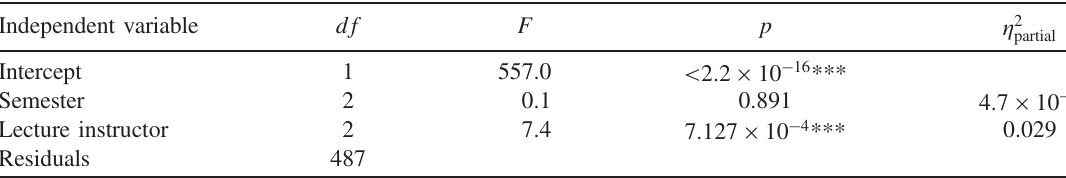
TABLE XIII. Results of two-way ANOVA (type III) conducted on student performance on CSEM posttest in Physics II with semester and lecture instructor as independent variables.